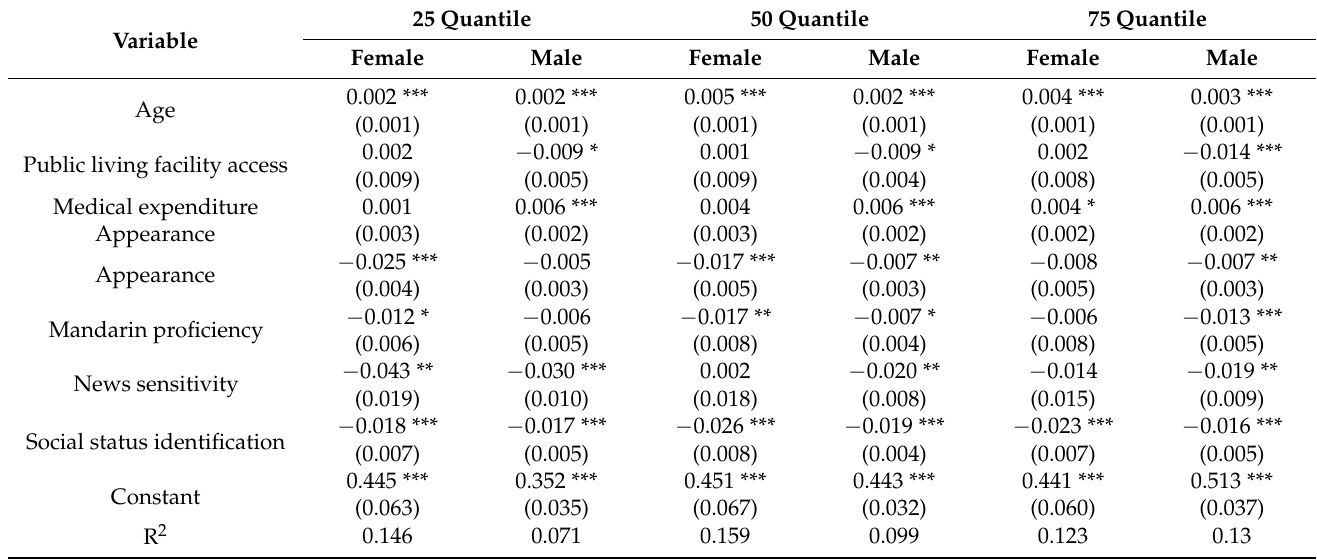
Table 5. Results for the UCQR of migrant workers’ relative